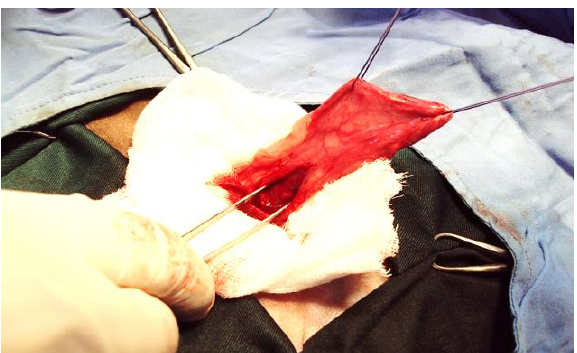
Figure, 2: Sterile gauze put around the bladder and two stay sutures are placed and the bladder is incised in its dorsal surface.